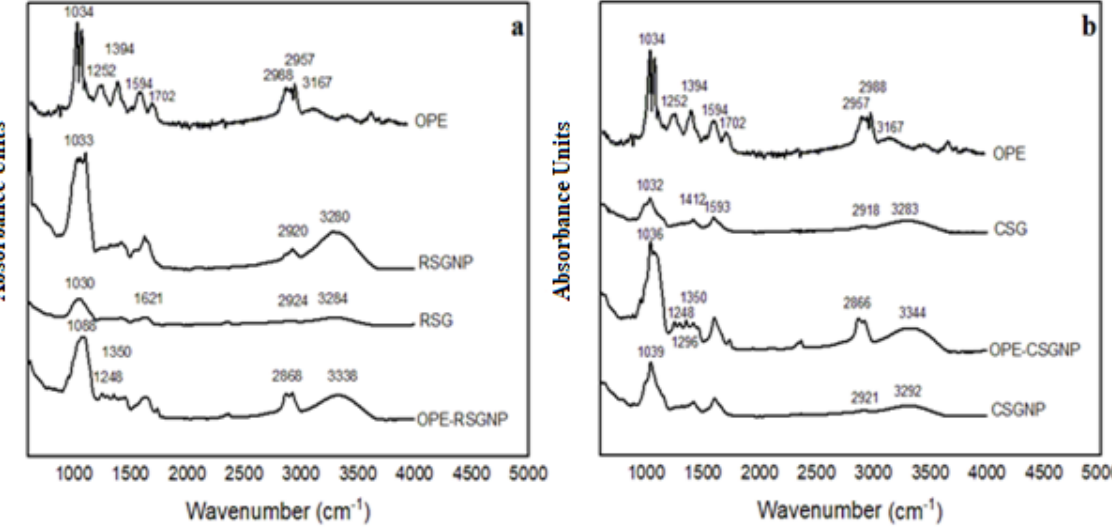
Figure 3. FTIR spectra of the ( a ) OPE, RSG, RSGNP, OPE-RSGNP, ( b ) OPE, CSG, CSGNP and OPE-CSGNP. The absence of a functional group of OPE on the FTIR spectra showed the efficient incorporation of the OPE in the RSG and CSGNPs [53]. The OPE-RSG NP and OPE-CSGNP mainly displayed the absorptions of RSG and CSG which are mostly overlapped with OPE. After the encapsulation, shifted FTIR spectrum bands were observed in Table 4. The OPE-RSGNP and OPE-CSGNP also presented peaks at 1248 cm − 1 and 1350 cm − 1 , which represented that C-O groups and deformation of OH, respectively, shifted compared to the OPE (1252.53 cm − 1 and 1394.69 cm − 1 ). The shift in wave numbers mean that interactions occurred between a phenolic compounds of OPE within the RSG and CSG, respectively. The higher broadening of the absorption peak at 3500–2600 cm − 1 after interaction with OPE led to increased intensity in this area, proven as O-H-O bonding, which indicated the improvement of hydrogen bonding in the OPE-loaded RSG and CSGNPs. The FTIR spectra of OPE had sharper peaks 1594 cm − 1 and 1702 cm − 1. which were not observed in OPE-RSGNPs and OPE-CSGNPs. These peaks were found to overlap with the broader peaks, ranging from 1750–1500 cm − 1 . These results indicated interaction between hydroxyl groups of OPE and RSG and CSG. These results recommended that OPE was encapsulated in the nanoparticles. FTIR results revealed that RSG, CSG, and OPE had interaction during nanoparticle formation and were in good accordance with DSC